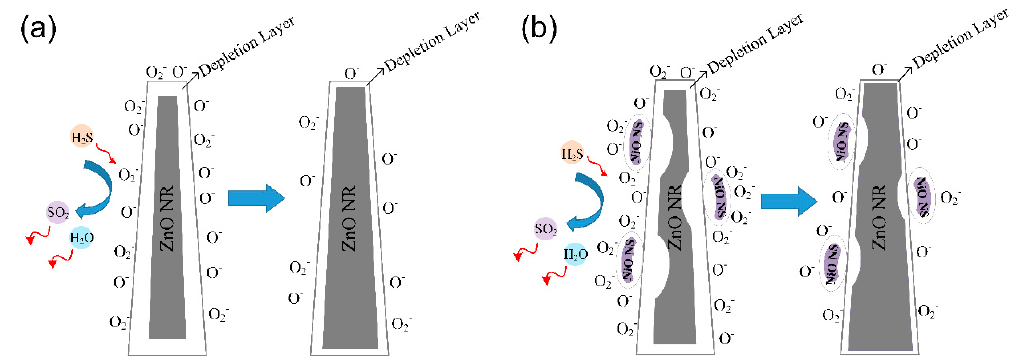
Figure 9. Schematic model for sensors exposed to H 2 S: ( a ) pure ZnO and ( b ) NiO/ZnO heterostructures.